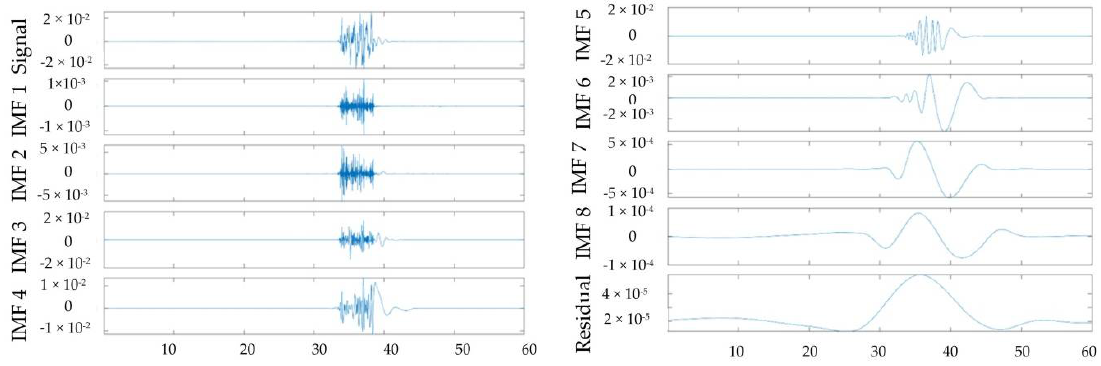
Figure 15. IMFs of a typical response of Segment 1.